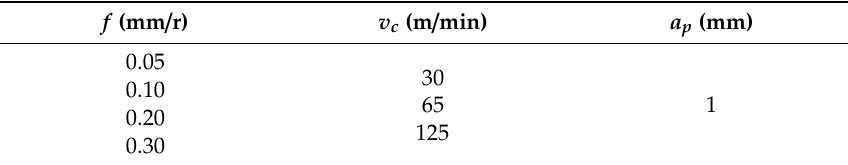
Table 2. Tested cutting parameter